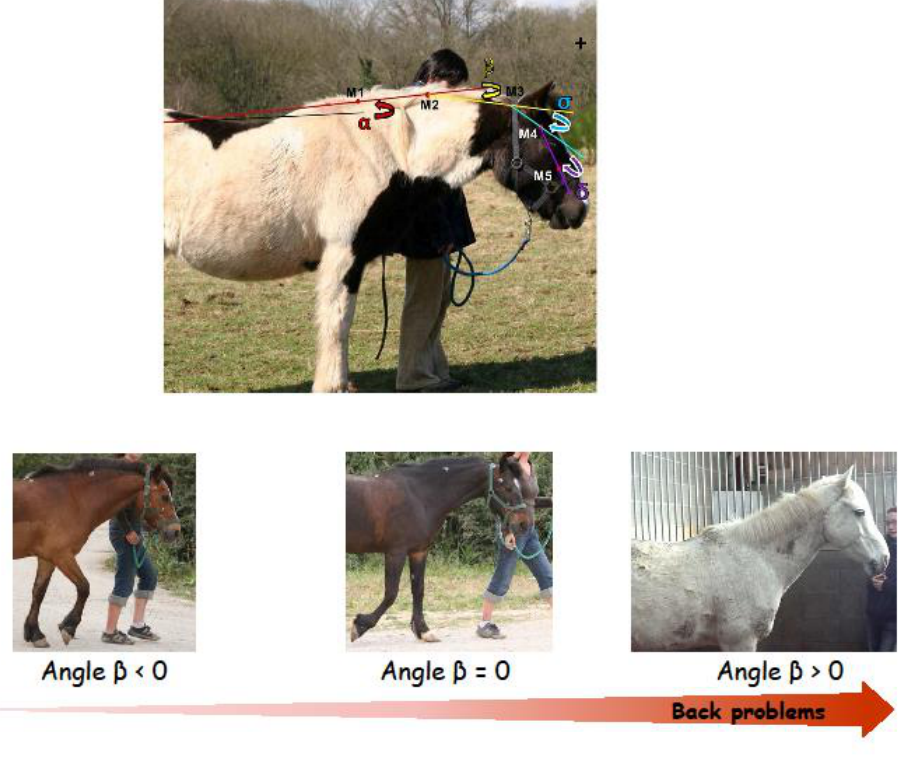
Figure 6. Representation of angles for neck posture measurement. α represents the neck’s elevation, β represents the neck’s curve and σ represent the M3–M5 angle (head-neck angle). On the left: round neck. In the middle: flat neck. On the right: hollow neck.